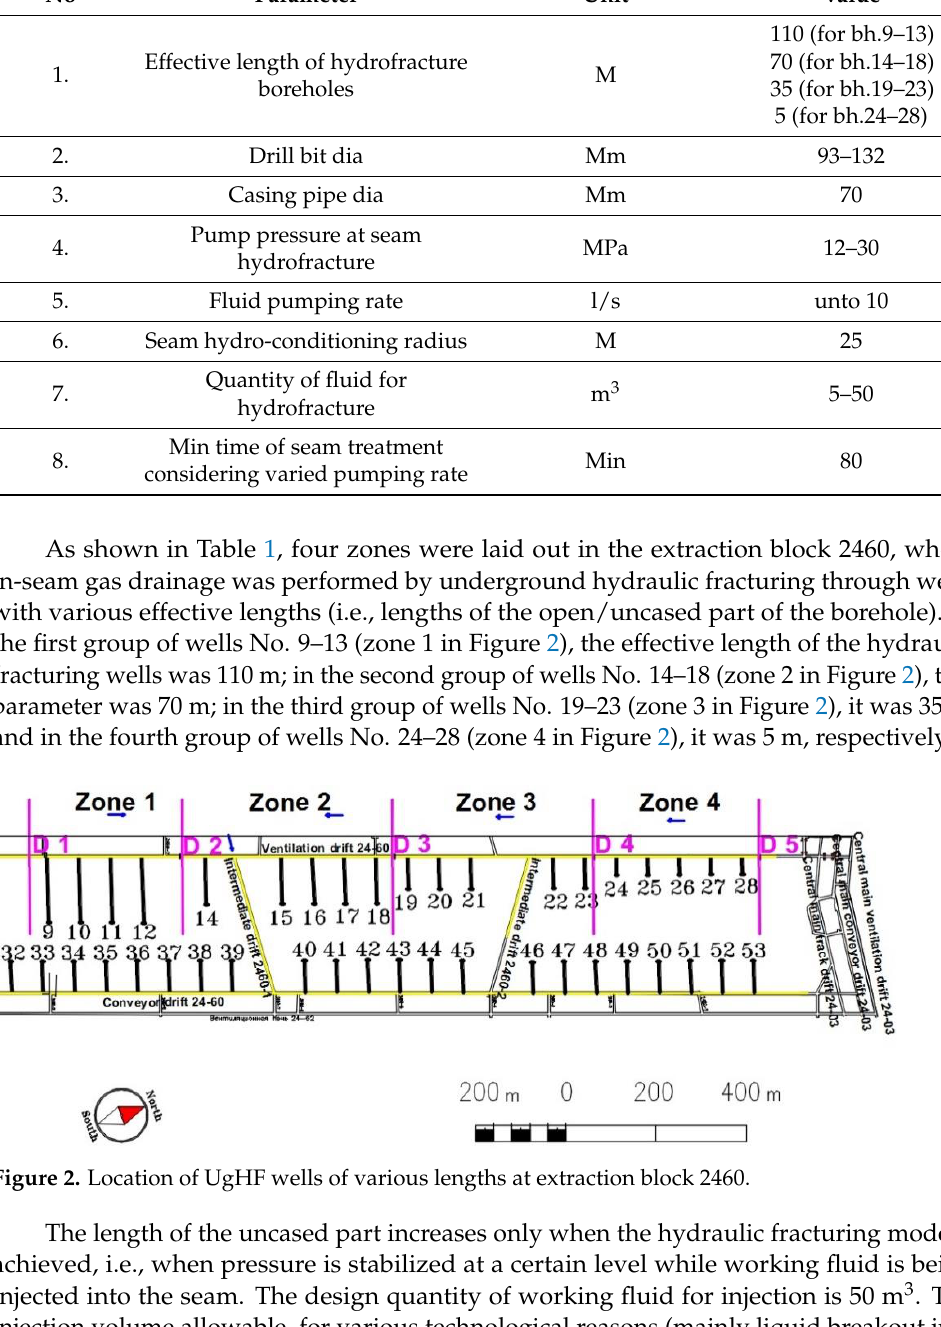
Table 1. Technical specifications of the ECBM for the block 2460 in Boldyrevsky seam (Hydrofracture location-vent. raise 2460).